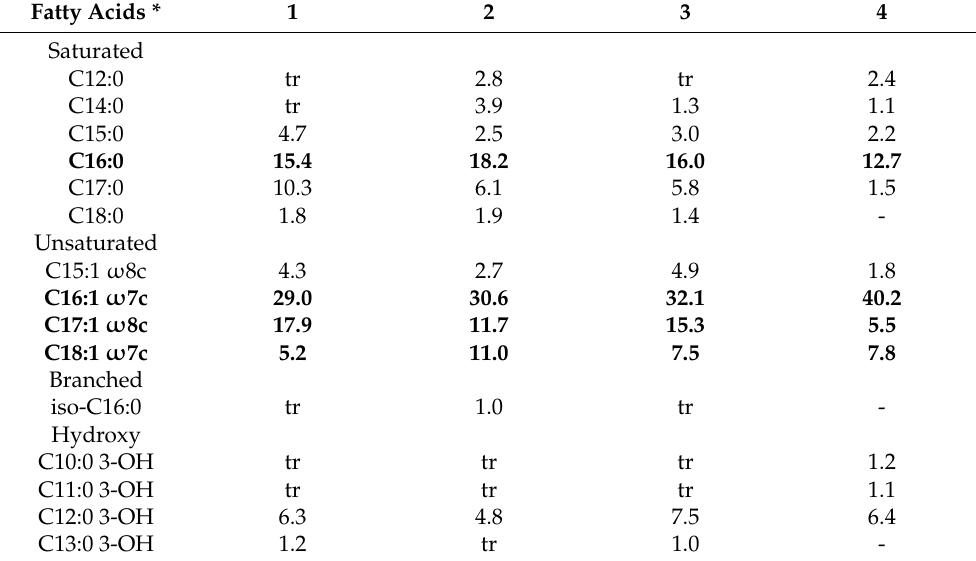
Table 2. Fatty acid composition (%) of strains belonging to the species P. distincta and P. arctica A